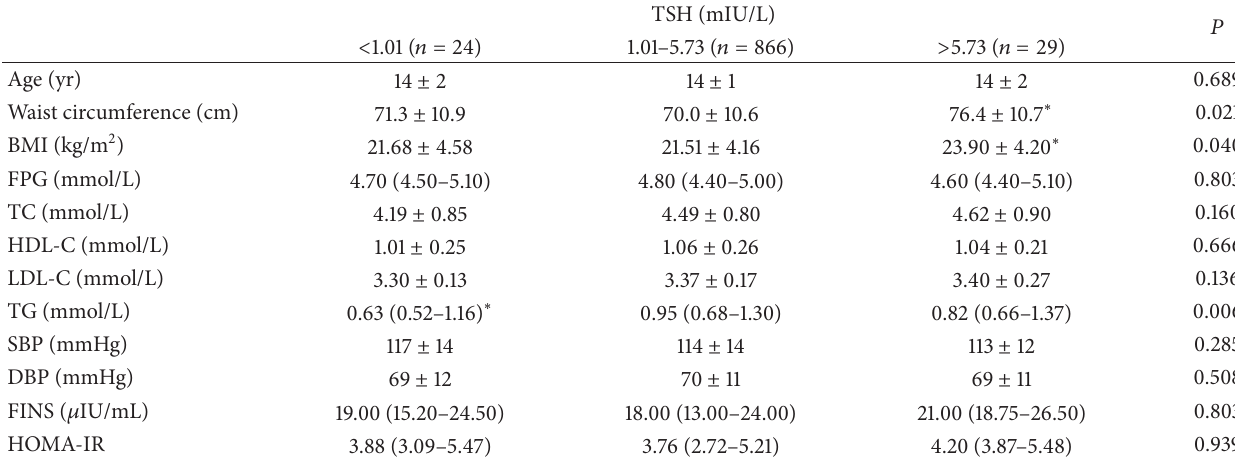
Table 1: Comparison of metabolic syndrome and its components in groups with different serum TSH levels.